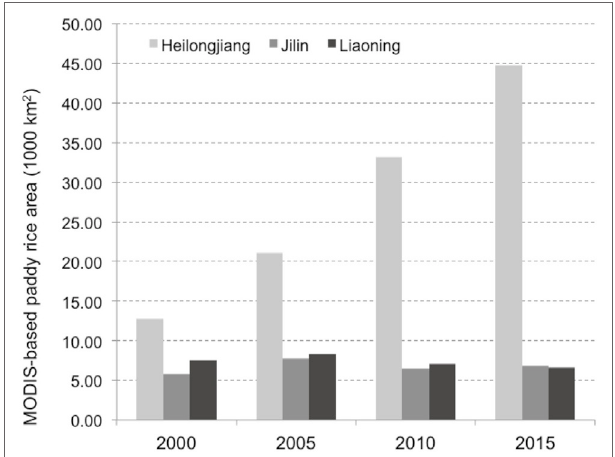
Figure 5 | Temporal distribution of rice harvested areas in different Chinese provinces over time, according to Zhang et al. (21).